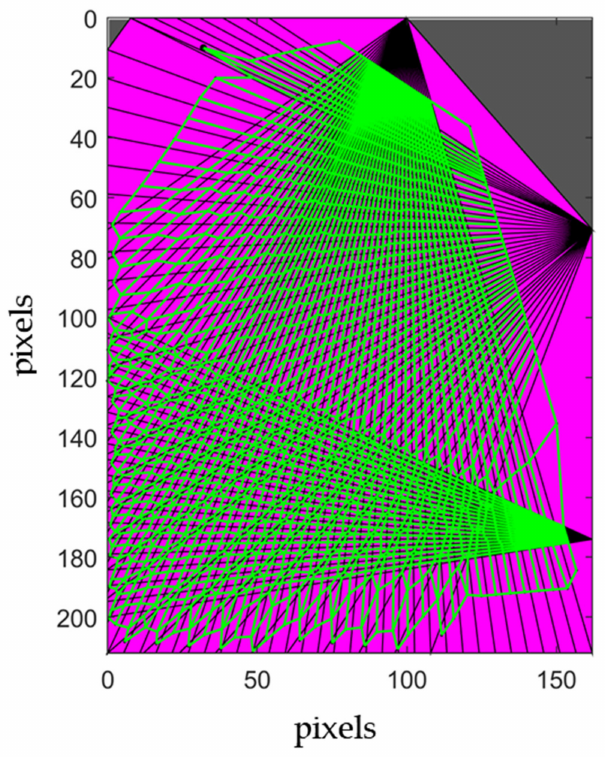
Figure 5. Beams-driven mesh (in